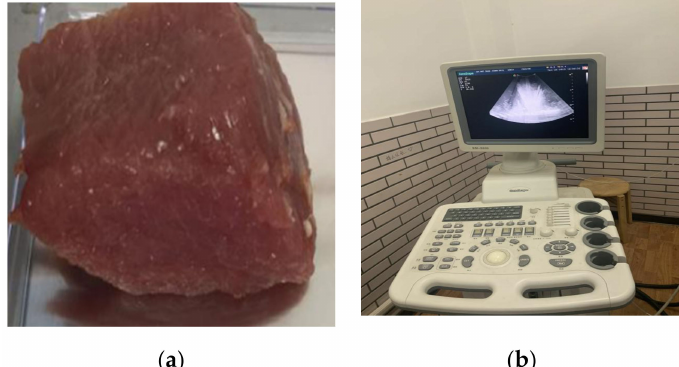
Figure 4. The pictures of porcine muscle tissue sample and B-mode ultrasonography. ( a ) porcine muscle tissue sample; ( b ) B-mode ultrasonography.